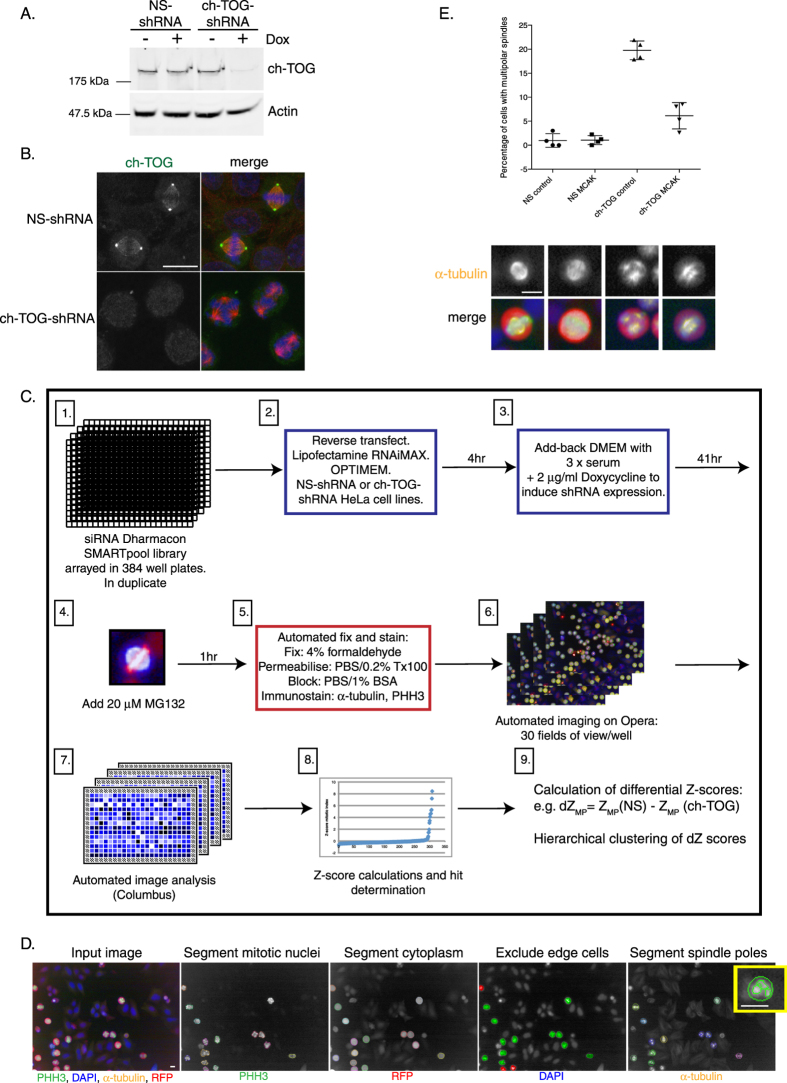
Setup of combinatorial RNAi screen. A. Western blot showing the extent of ch-TOG protein reduction 42 hr after Doxycycline (Dox) induction in a cell line stably expressing ch-TOG shRNA. β-actin is used as a loading control. B. Images showing that ch-TOG is depleted from the centrosomes and spindle MTs 42 hr after Dox addition. ch-TOG is in green, α-tub in red and DNA in blue in merged images. C. Workflow of RNAi screen. D. Image segmentation workflow to identify mitotic nuclei, segment mitotic cells and detect spindle poles. In yellow is a zoomed image from the final panel to show spindle pole segmentation. Scale bars are 10 μm. E. Graph showing the quantification of validation experiments. Mean +/− standard deviation (STD) of n =  4 is shown. Underneath the graph are representative images taken from the screening data to show the spindle phenotypes of each of the four conditions shown in the graph. α-tubulin is in yellow, PHH3 in green, RFP in red and DNA is in blue in merged images. All scale bars represent 10 μm.